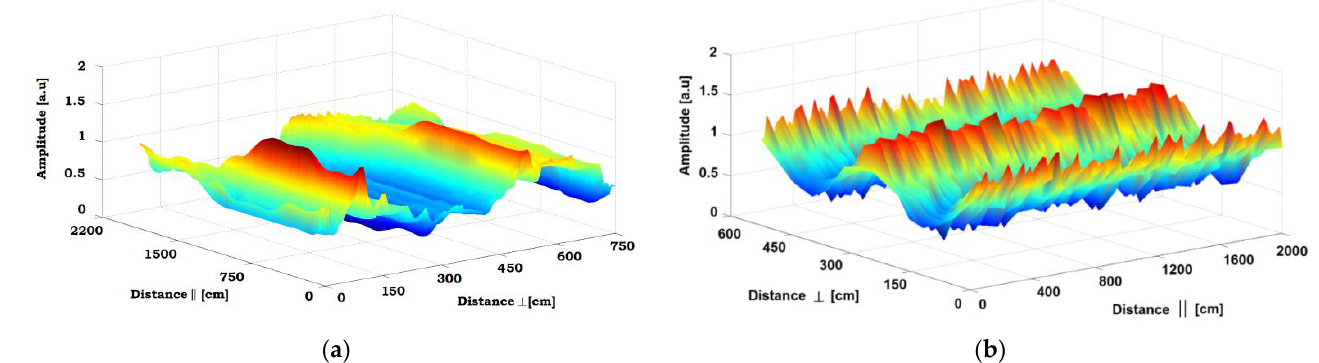
Figure 9. Drainage water pipes reconstruction: ( a ) before and ( b ) after processing.